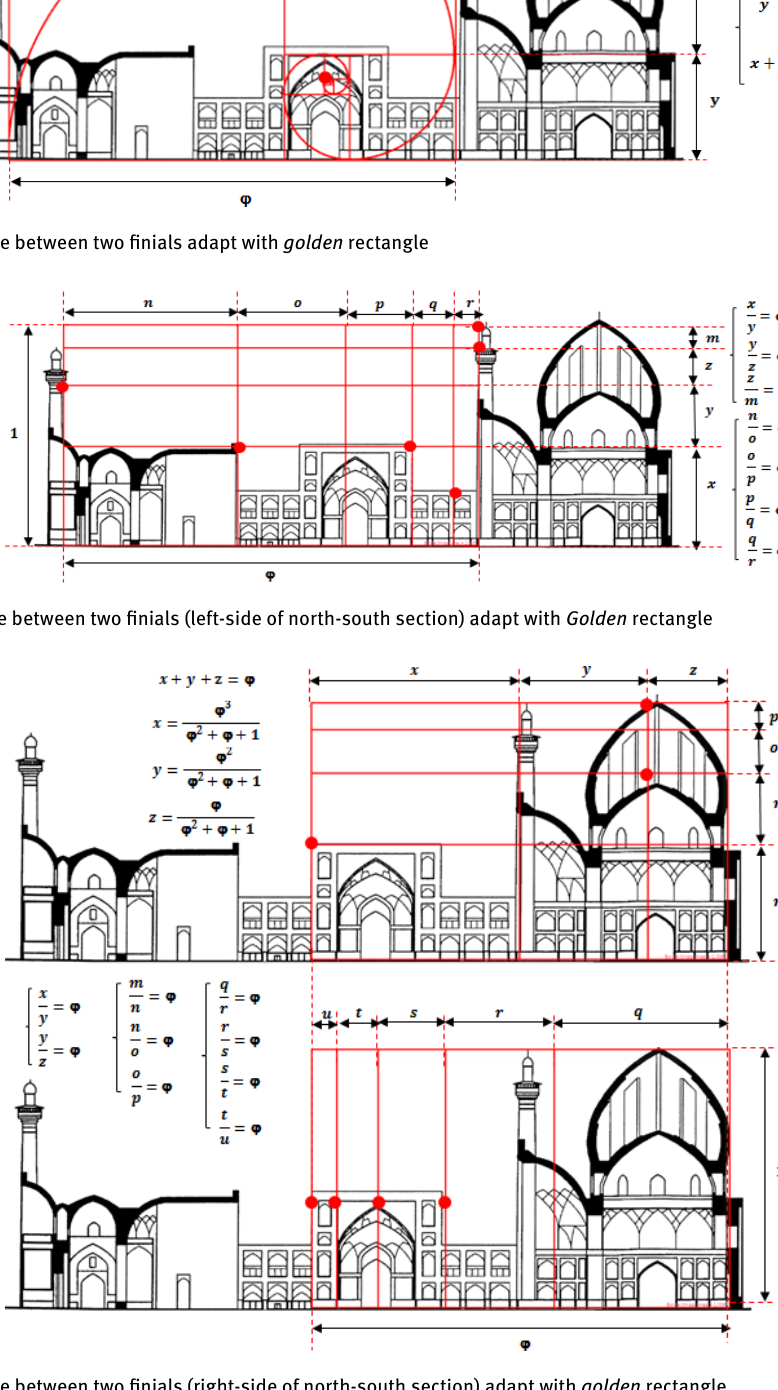
Figure 12: Abstract frame between two finials (right-side of north-south section) adapt with golden